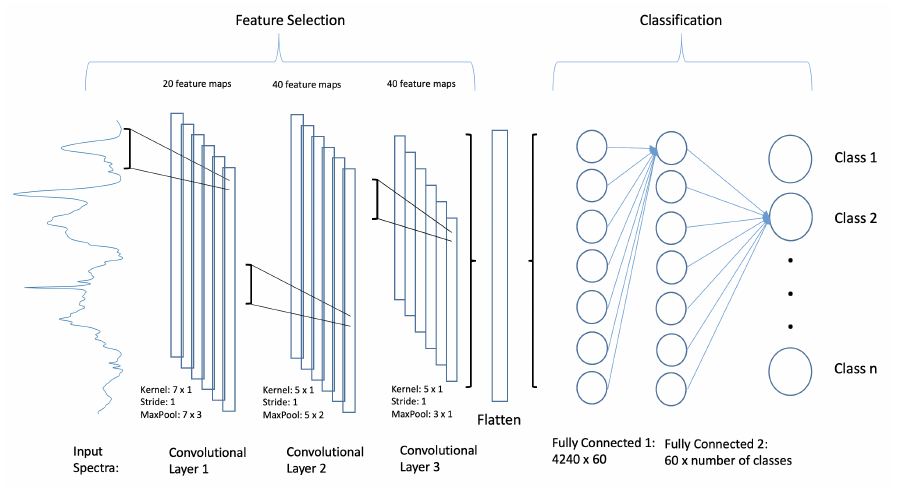
Figure A2. CNN architecure. Table A1. CNN